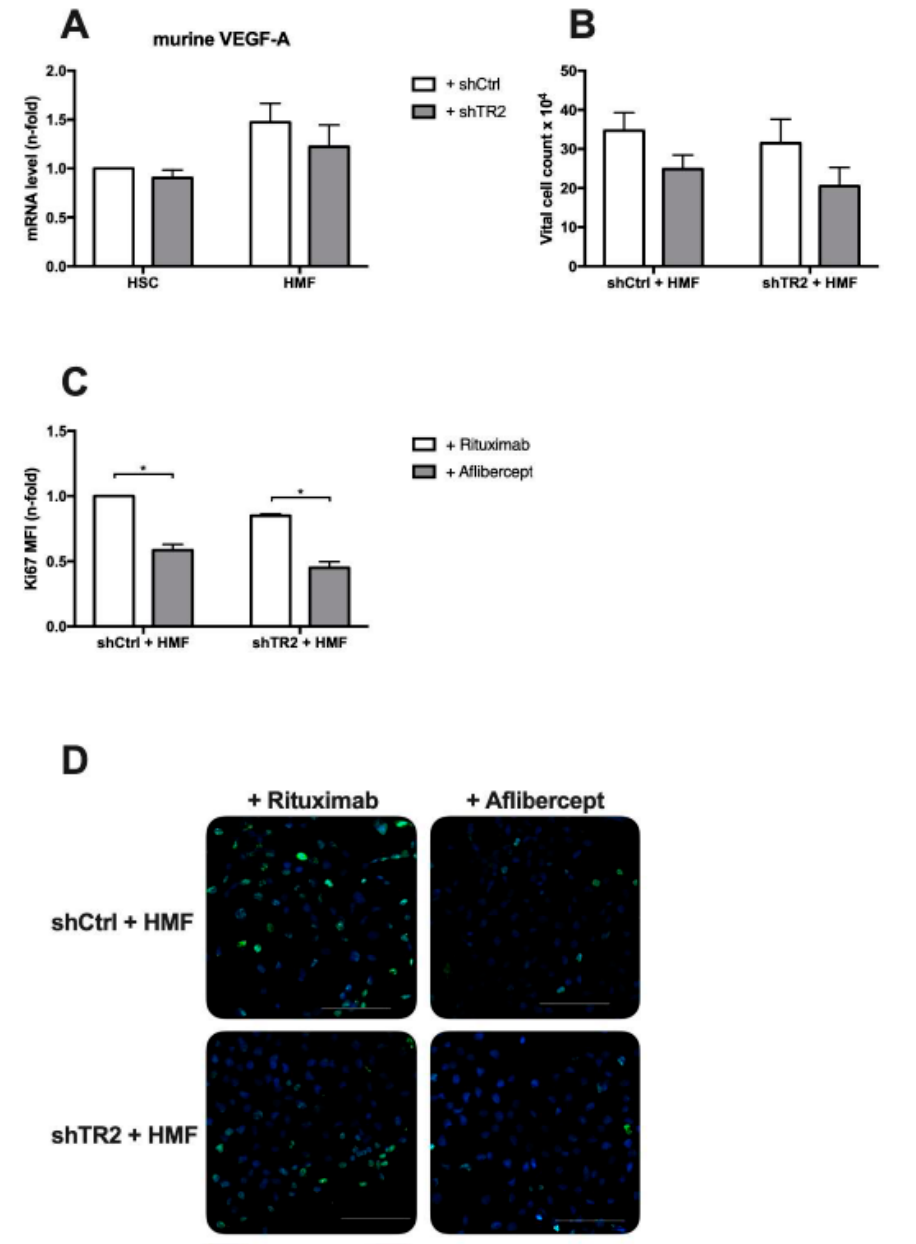
Figure 8. HMF-mediated proliferation boost of PancTu-I cells is VEGF dependent. ( A ) RNA was isolated from HSC or HMF after 6 days of coculture with PDAC cells and mRNA levels of murine VEGF-A were analyzed by qRT-PCR. VEGF-A gene expression was normalized to GAPDH expression and normalized expression of HSC cocultured with PancTu-I shCtrl cells was set as 1. For blocking experiments, PancTu-I shCtrl or PancTu-I shTR2 cells were indirectly cocultured in the presence of HMF and treated with 10 µ g / mL of either Rituximab as control or Aflibercept. After 6 days of coculture, ( B ) vital cell count and ( C ) the proportion of Ki67 + cells were determined. The percentage of proliferating cells was determined by immunofluorescence Ki67-Alexa-488 staining. Data are normalized to PancTu-I shCtrl cells + HMF treated with Rituximab. ( D ) Representative images of immunofluorescent Ki67 staining are shown. Scale Bars: 100 µ m. Data represent the mean ± SEM of 4–5 independent experiments; * = p < 0.05.